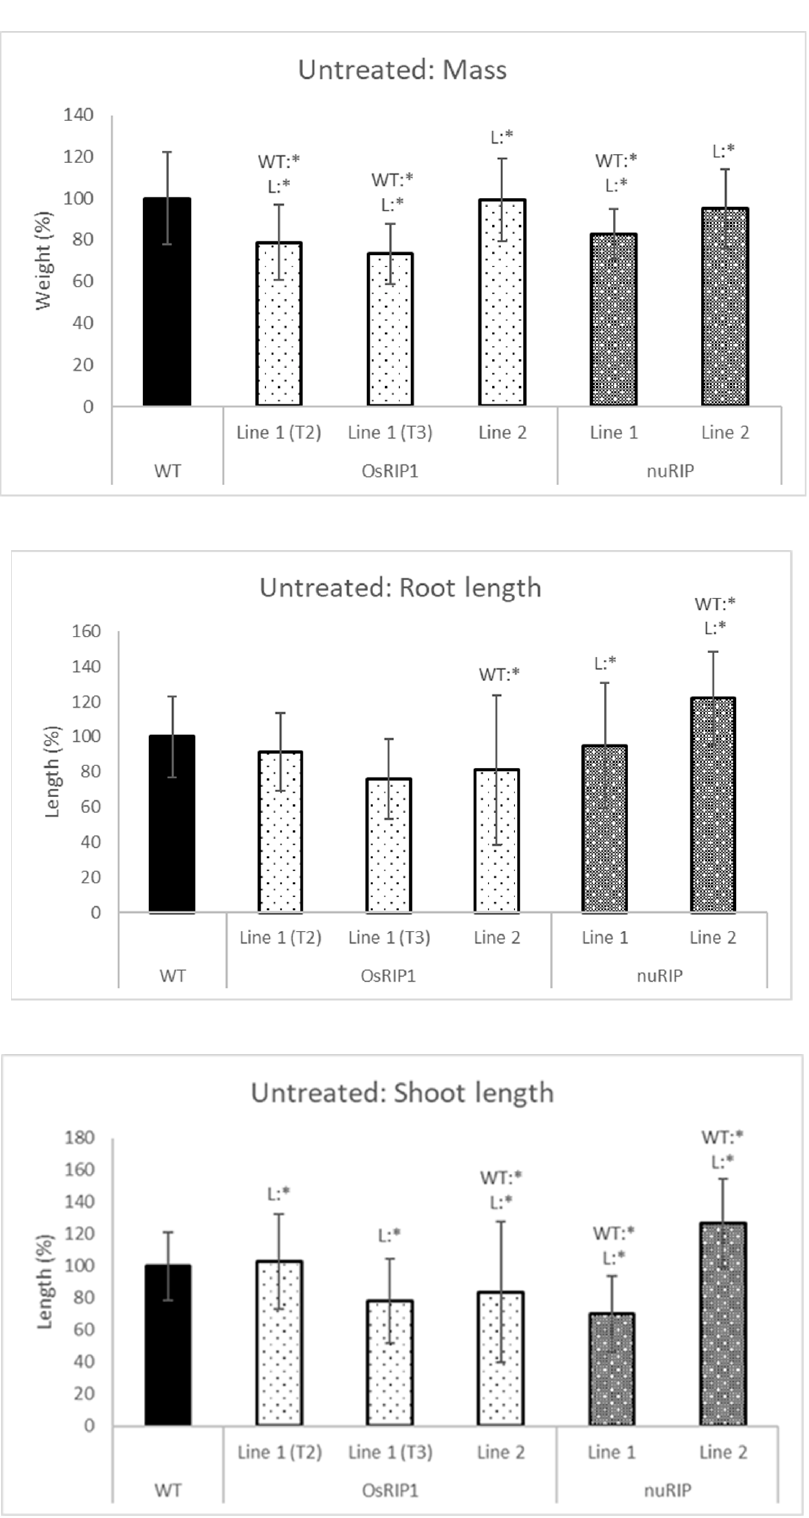
Figure 6. Total mass, shoot and root length of one-week-old plants from different transgenic lines compared to wild-type plants. WT:* refers to a significant difference to wild-type plants. L:* indicates a significant difference to the other transgenic line of the same construct. The histogram is based on averages; error bars represent the standard deviation. Each data point is gathered from 50 plants per line.